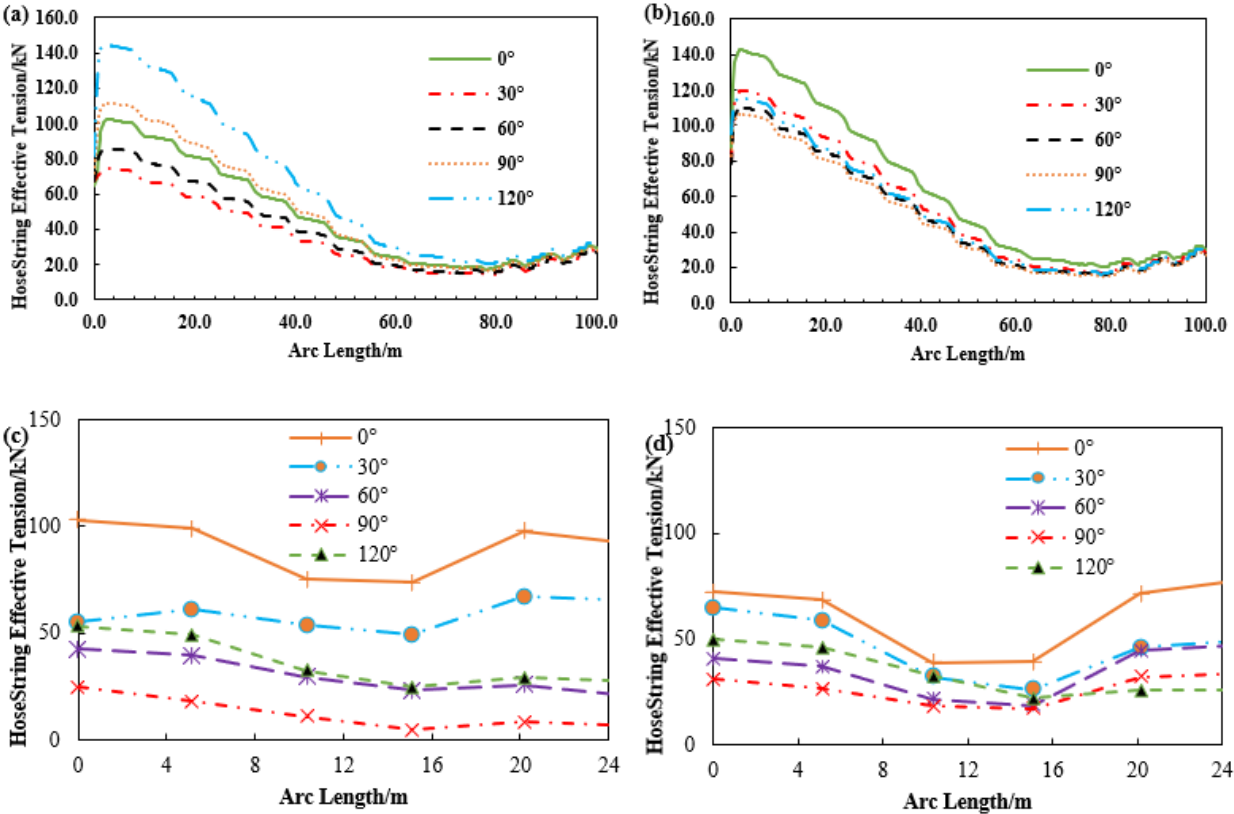
Figure 22. Influence of loadings from hydrodynamics on the effective tension of the submarine hose. ( a ) Coupled Hose Effective Tension in Lazy-S config. ( b ) Uncoupled Hose Effective Tension in Lazy-S config. ( c ) Coupled Hose Effective Tension in Chinese-lantern config. ( d ) Uncoupled Hose Effective Tension in Chinese-lantern config.